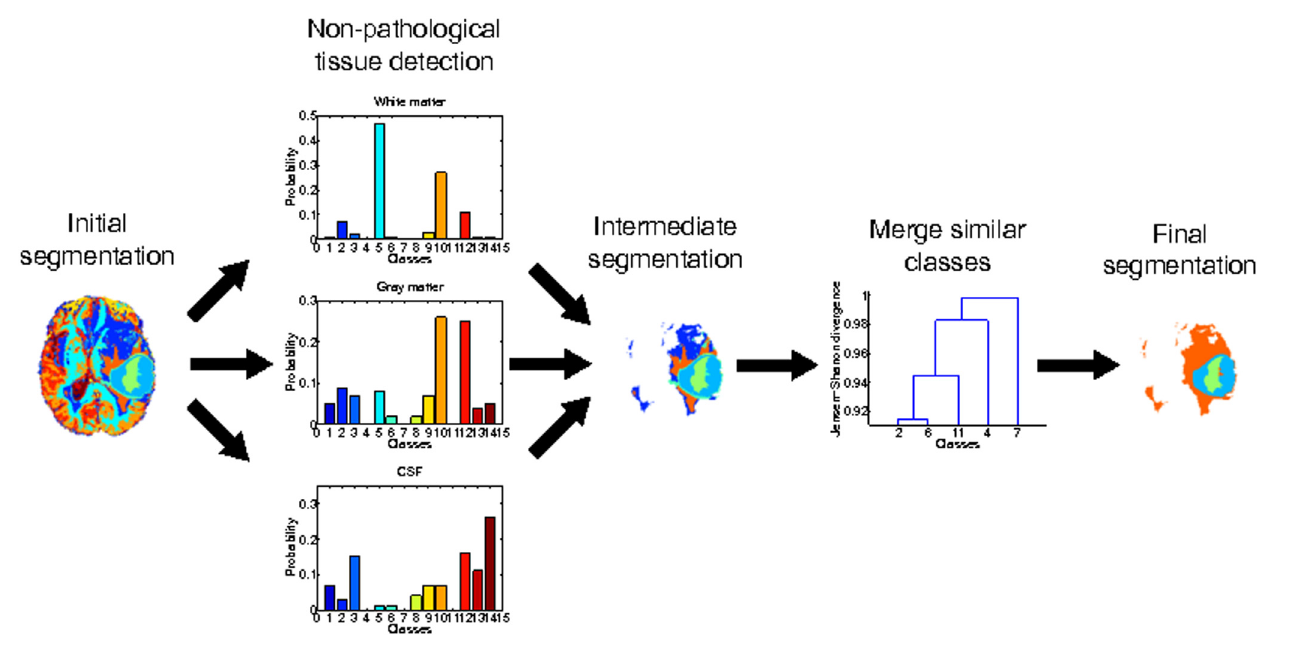
Fig 5. Automatic tumour class isolation